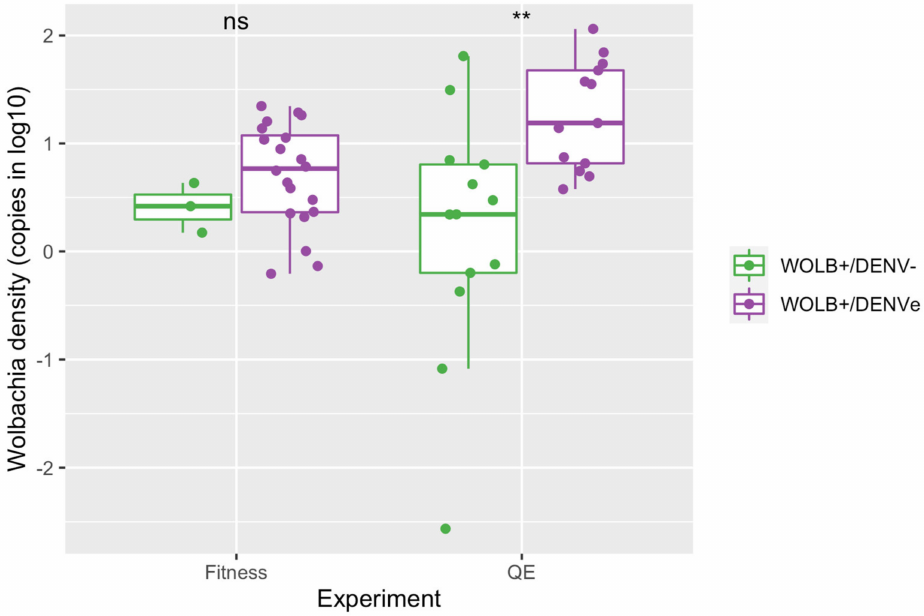
Figure 2. Wolbachia quantification comparing WOLB+/DENVe and WOLB+/DENV − mosquitoes from fitness (~21 days old) and quiescent eggs (QE) (~28 days old) experiments. Dots represent individual mosquitoes from the WOLB+ groups. ** indicates statistically significant differences ( p <